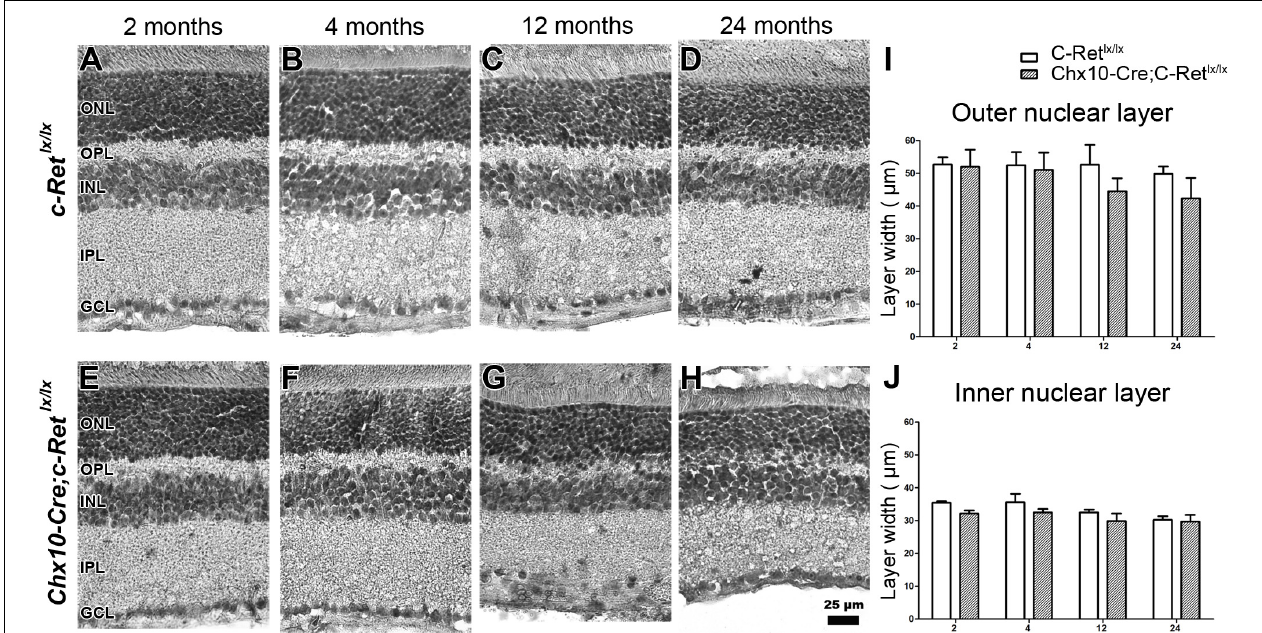
FIGURE 4 | Morphological examination of C-Ret lx / lx and Chx10-Cre;C-Ret lx / lx mice. Hematoxylin staining of the retinas of C-Ret lx / lx (A–D) and Chx10-Cre;C-Ret lx / lx (E–H) mice was performed at 2, 4, 12, and 24 months of age. At the age of 2 and 4 months, the OPL in Chx10-Cre;C-Ret lx / lx retinas was slightly thinner than that in C-Ret lx / lx mice (A,B,E,F) . Furthermore, this phenomenon was detected in the OPL of Chx10-Cre;C-Ret lx / lx retinas which became worse, and their retina even showed disorganization at the ages of 12 and 24 months (C,D,G,H) . The thickness of the ONL and INL was measured in three animals per group at the ages of 2, 4, 12, and 24 months (I,J) . The ONL in Chx10-Cre;C-Ret lx / lx retinas was thinner than that in C-Ret lx / lx retinas at the ages of 12 and 24 months, albeit with no statistical significance at either of the stages (I) . Similarly, the INL in Chx10-Cre;C-Ret lx / lx retinas was slightly thinner (albeit not significantly) than that in C-Ret lx / lx retinas (J) . An independent t -test was used in this analysis, and significance was set at P < 0.05. ONL, outer nuclear layer; OPL, outer plexiform layer; INL, inner nuclear layer; IPL, inner plexiform layer; GCL, ganglion cell layer. Scale bar, 25 µ